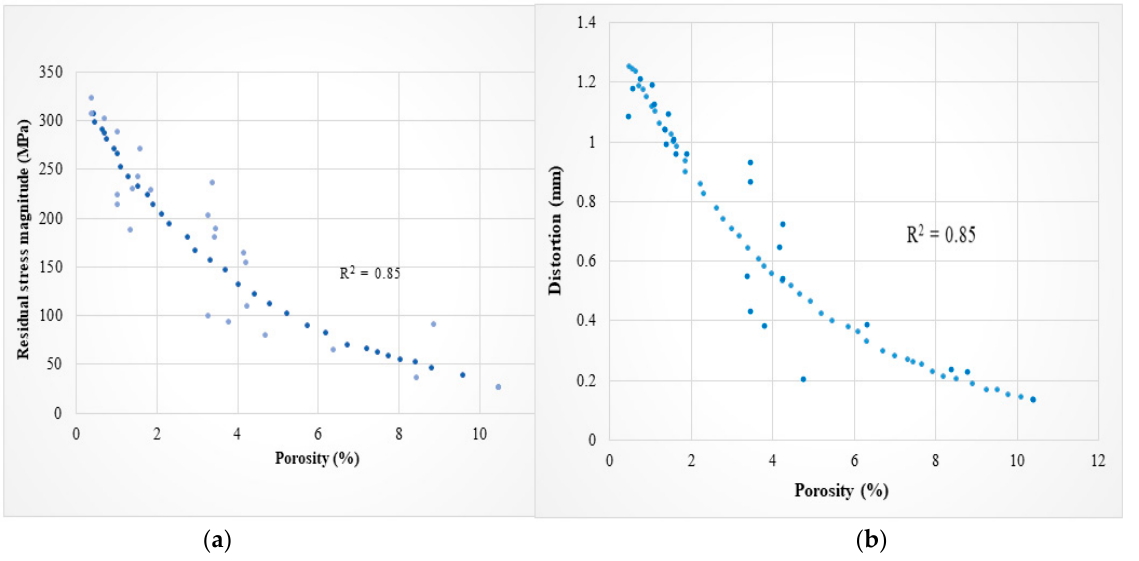
Figure 7. SLM interdependencies: ( a ) Porosity residual stresses, ( b ) Porosity distortions (Adapted from [115] with permission in accordance with Creative Common CC BY license, open access).